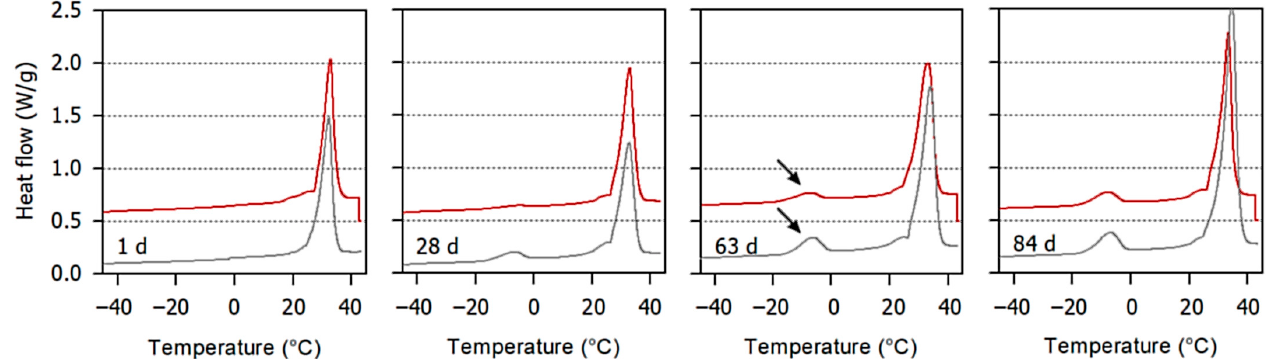
Figure 4. Average melting curves (endo up, n = 2) of chocolate on top of nougat stored for different periods of time (1, 28, 63, and 84 days). Grey lines, chocolate on top of control nougat; red lines, chocolate on top of nougat #A. The nut oil melting peak is marked by an arrow. For the sake of clarity, the red lines are shifted along the y-axis by 0.5 W/g.